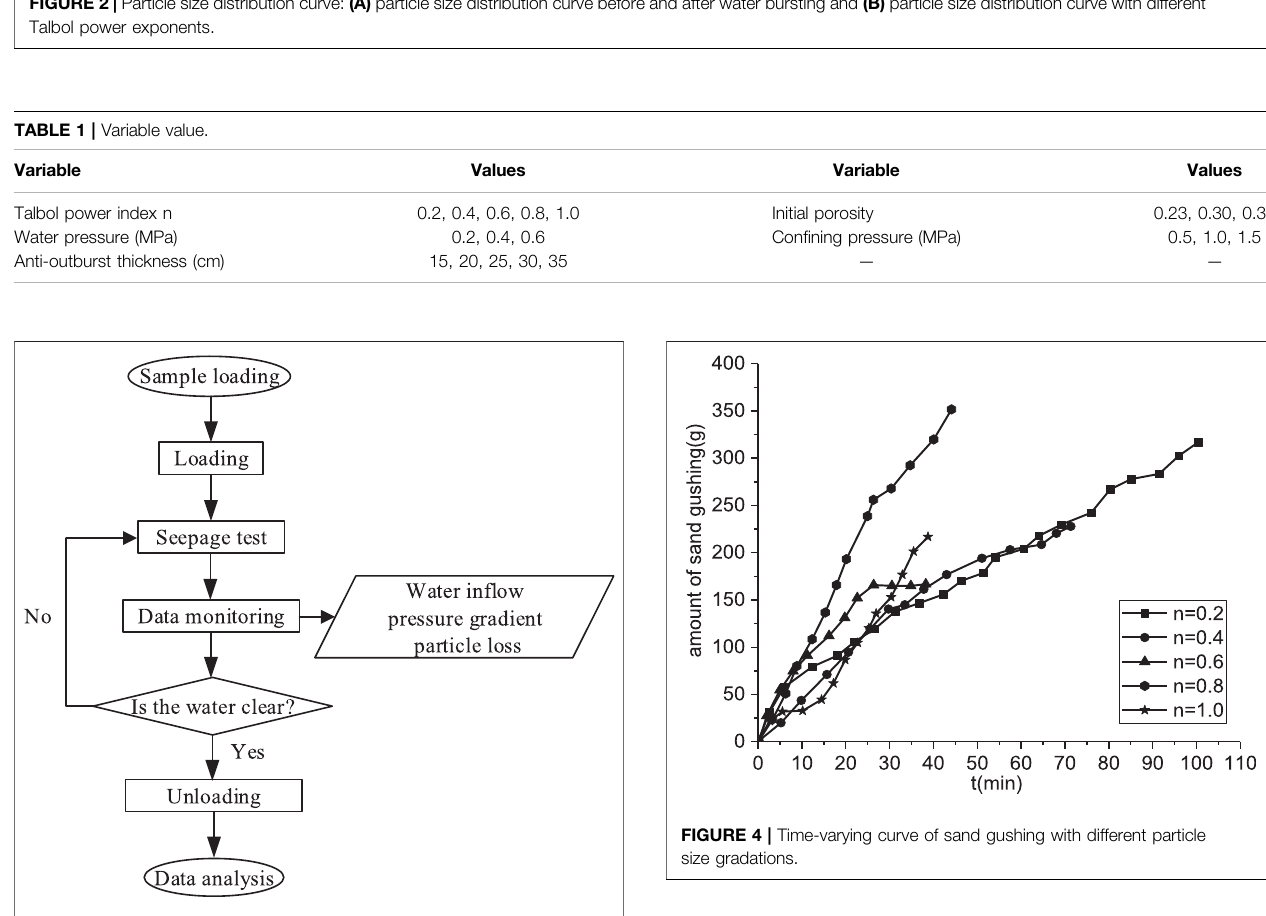
FIGURE 3 | Test procedure.